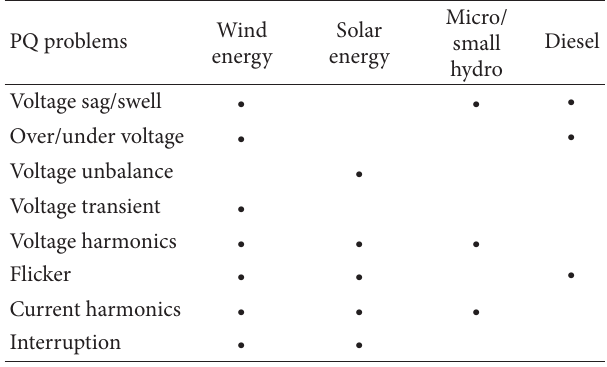
Table 3: PQ problems related to DG systems